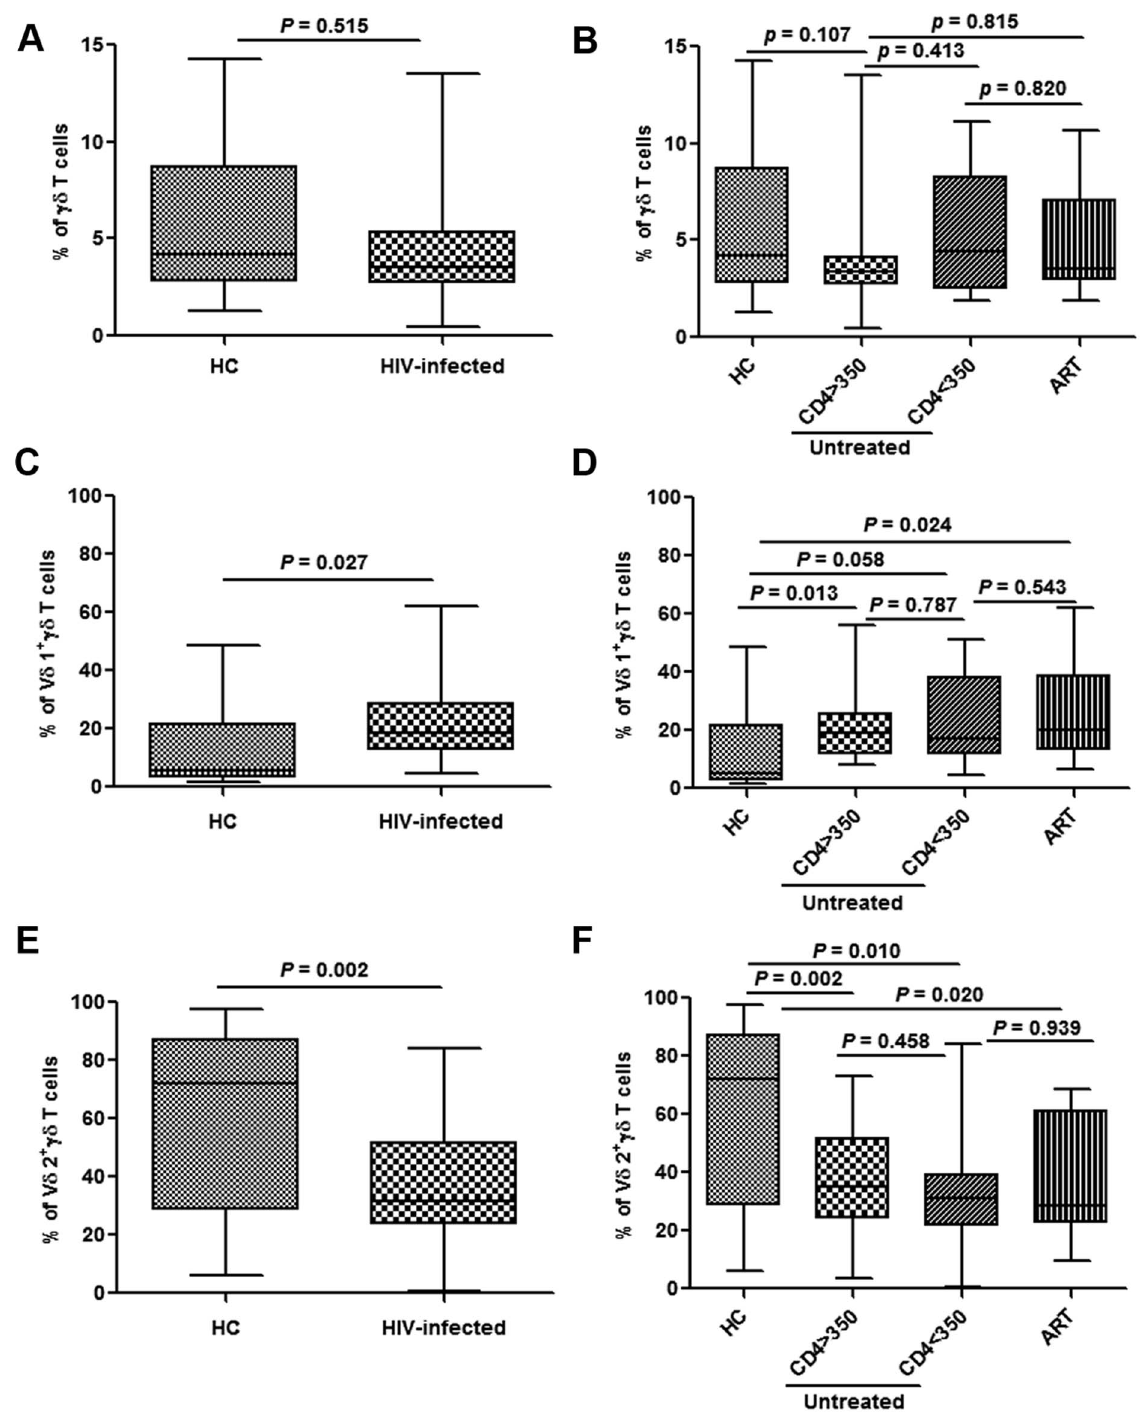
Figure 1. Changes in different subpopulations of cd T cells in acutely HIV-infected patients. Frequencies of total cd T cells, V d 1 cd T and V d 2 cd T cells were analyzed in healthy controls (HC) and acutely HIV-infected subjects at baseline ( A, C, E ). The patients were then subdivided based on the administration of antiretroviral therapy (ART) and CD4 levels ( , or . than 350/ m L). The frequencies were re-analyzed and compared with HC ( B, D, F ).